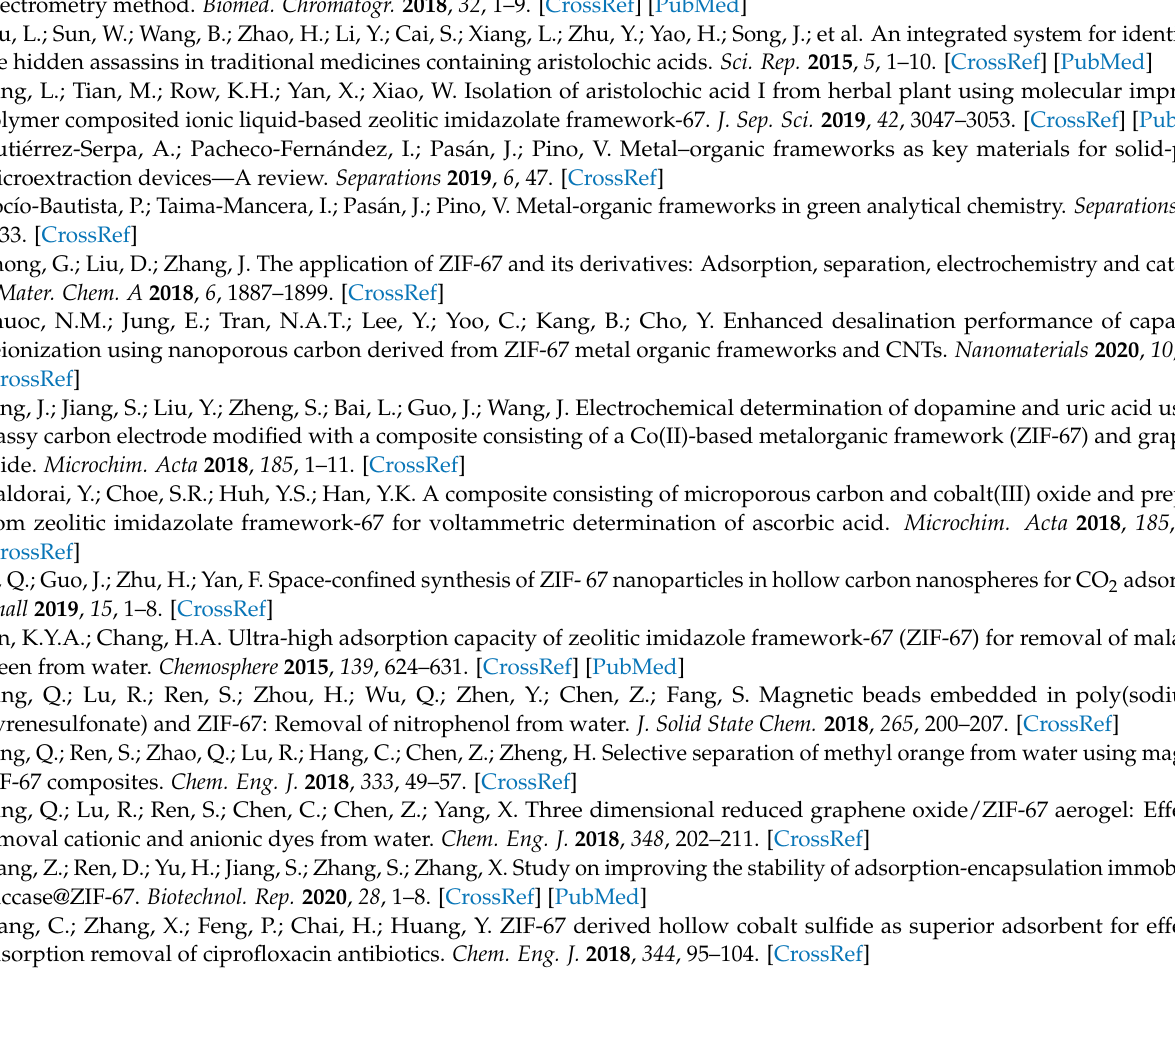
Figure S8: The adsorption of AAI onto three dual IL-immobilized ZIF-67 sorbents at 25 ◦ C with the pseudo-second-order